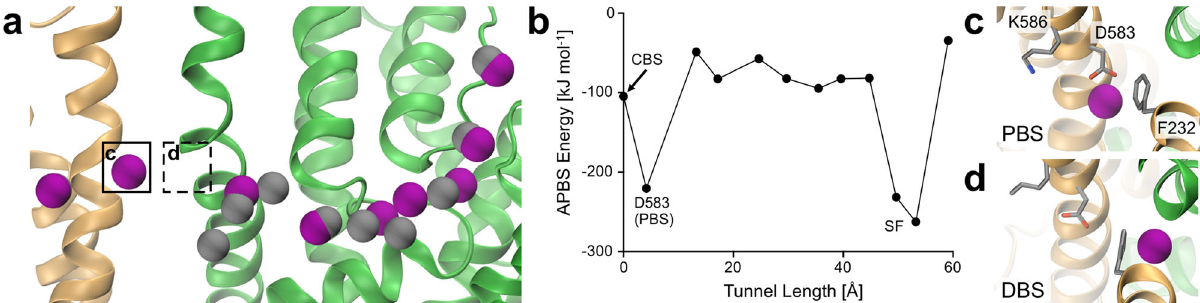
Fig. 4 Occupancy and energetics of K + ions in the intersubunit tunnel in MD simulations. a Comparison of K + positions from cryo-EM (gray) and at the endpoint of a short atomistic MD relaxation (purple). The ions rearrange slightly but remain in the intersubunit tunnel, indicating its viability for translocation. A new ion position is taken up adjacent to the CBS. b APBS coordination energy pro fi le for K + along the length of the intersubunit tunnel. Coordination is optimal at the KdpA SF, where ions are fully dehydrated by the protein, and immediately before the KdpB CBS, where they are bound by KdpB D583 . c , d New coordination sites around KdpB F232 observed in atomistic MD simulations. During the progression towards the CBS, ions are likely coordinated by cation – π interactions on both faces of KdpB F232 . Coordination in the PBS ( c ) is strong, with coordination supported by KdpB D583 . Coordination in the DBS ( d )